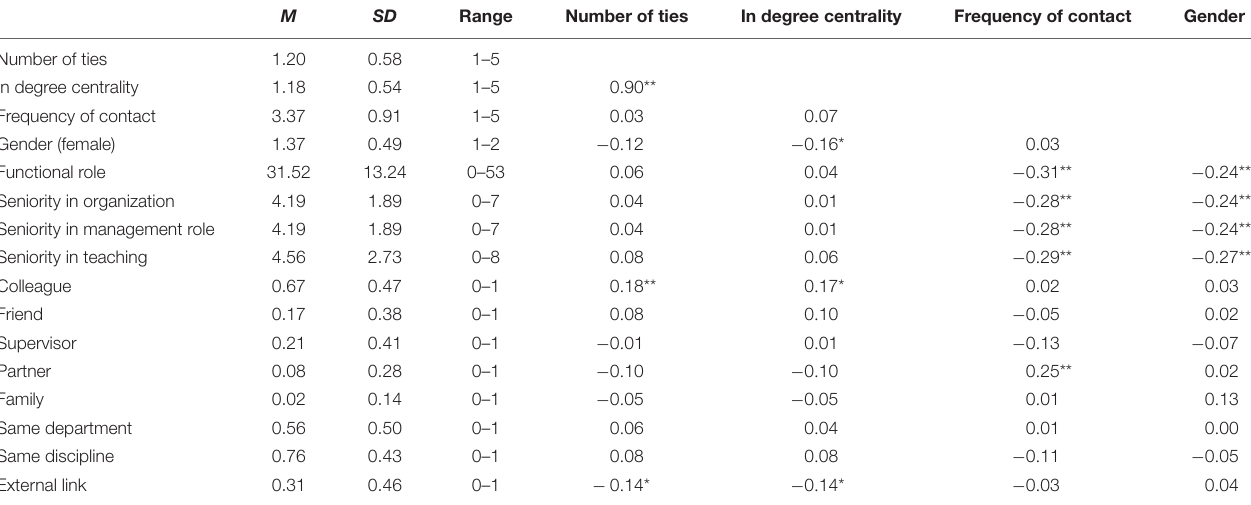
TABLE 1 | Basic descriptive and correlation matrix of external connectors.